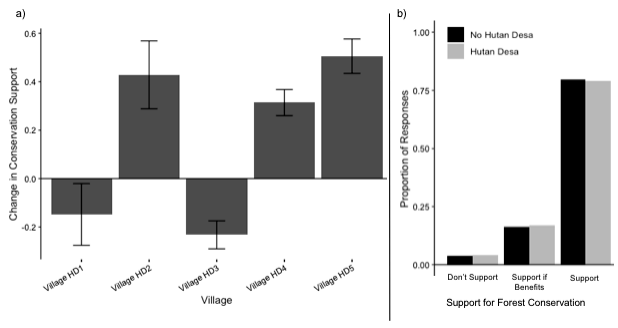
Fig. 7 . (a) Average change in level of support for conservation in villages with a Hutan Desa between 2012 and 2017. (b) Level of support for forest conservation in 2017 for villages with and without Hutan